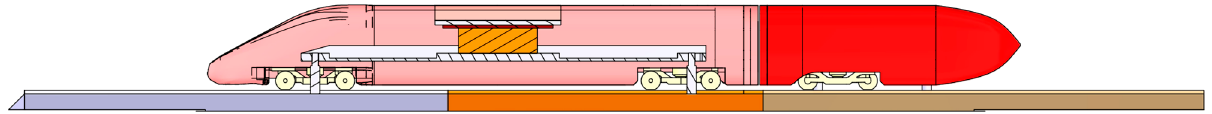
Figure 3. Internal setup for the connection of the dynamometric balance to the train scaled model.